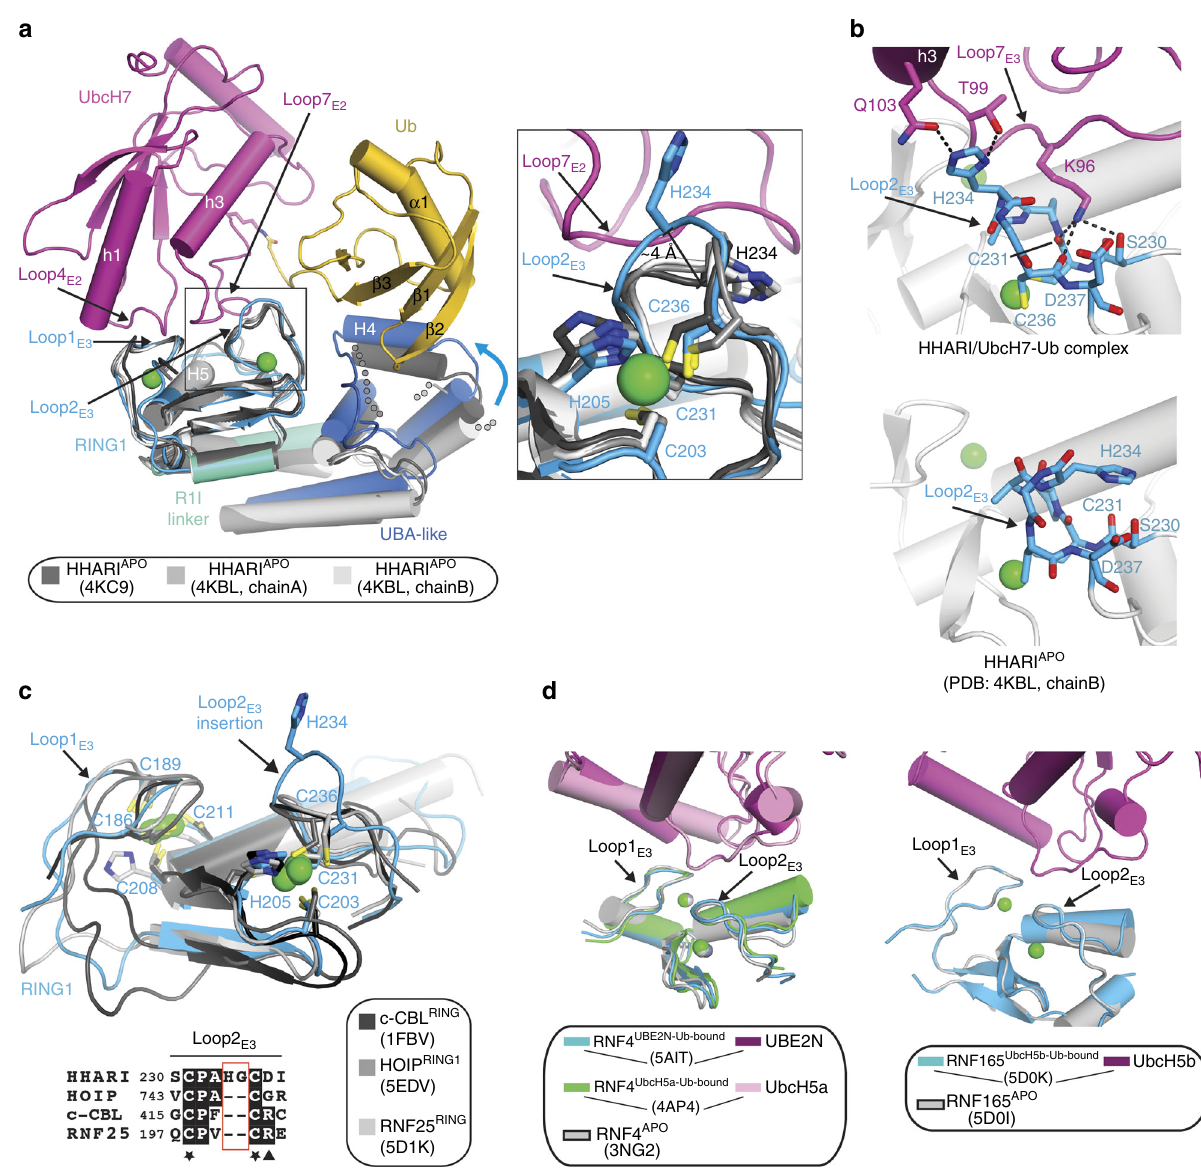
Fig. 2 HHARI conformational changes accompany UbcH7-Ub binding. a Comparison of HHARI structures in the apo and UbcH7-Ub-bound states. The RING1 domains of the structures were superimposed. The HHARI/UbcH7-Ub structure is colored as in Fig. 1b and the three available apo HHARI structures are colored the indicated shade of gray . The RING1 Loop2 E3 region of HHARI is boxed and a magni fi ed cartoon representation of this region is presented as an inset to the right . The distance between the C α atoms of His234 from Loop2 E3 of apo and UbcH7-Ub bound HHARI structures is shown. Disordered regions in the UBA-like domains of apo HHARI that become ordered upon UbcH7-Ub binding are shown as semitransparent gray spheres . b The HHARI/ UbcH7-Ub ( top ) and HHARI APO ( bottom ) structures are shown as cartoon representations in the same orientation with selected residues shown as sticks . c Comparison of the HHARI RING1 domain to the RING domains of HOIP, c-Cbl, and RNF25. The C α atoms of the eight residues involved in coordination of two zinc ions ( green spheres ) were superimposed and the structures are shown as cartoon representations with selected side chains shown as sticks . A sequence alignment of the Loop2 E3 region of the RING domains is shown at the bottom with the loop insertion of HHARI boxed in red and highly conserved residues colored black . Cysteine residues involved in zinc coordination are indicated with a black star and the ‘ linchpin ’ arginine residue of canonical RING E3s that is involved in stabilization of the closed E2~ Ub conformation is indicated with a black triangle . d Comparison of the apo and E2-Ub bound crystal structures of RNF4 and RNF165. The structures are shown as cartoon representations the RING domains were superimposed to create the